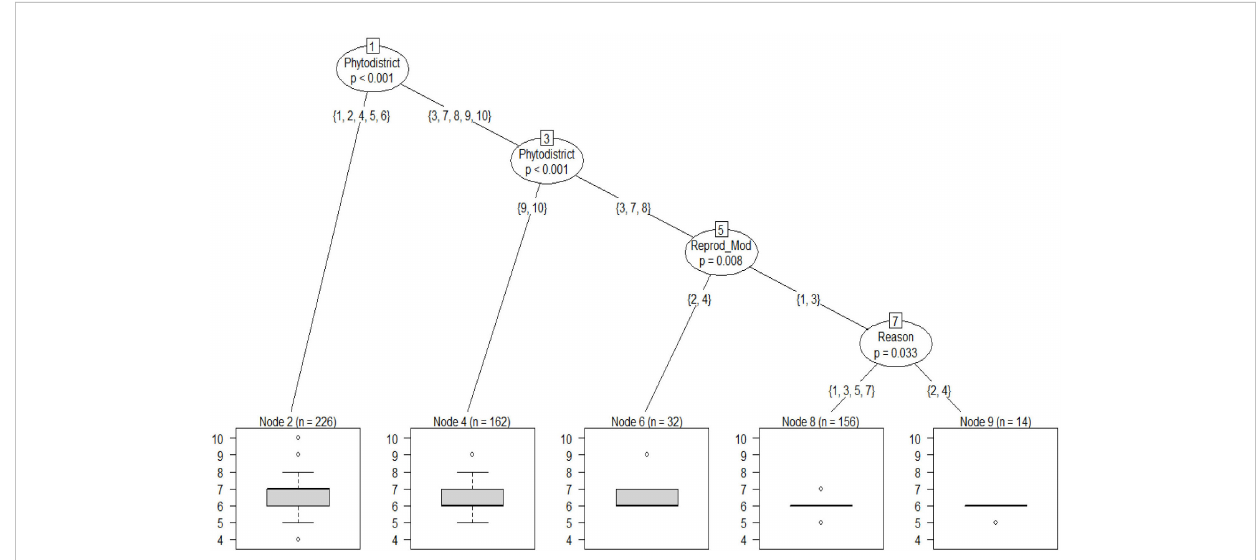
FIGURE 6 Effects of species ecological factors on ethnomedicinal knowledge. Legend: phytodistricts. 1: Co ̂ tier; 2: Pobè; 3: Oueme Valley; 4: Plateau; 5: Zou; 6: South Borgou; 7: Bassila; 8: North Borgou; 9: Atacora Chain; 10: Me ́ krou-Pendjari. Legend: reproduction mode. 1: young plants; 2: roots; 3: seedling; 4: slipping/cutting. reasons of species unavailability. 1: carbonization; 2: overexploitation of roots for medicine; 3: overexploitation for wood (technology); 4: species ecology; 5: extensive agriculture; 7: cut to avoid habitation by evil